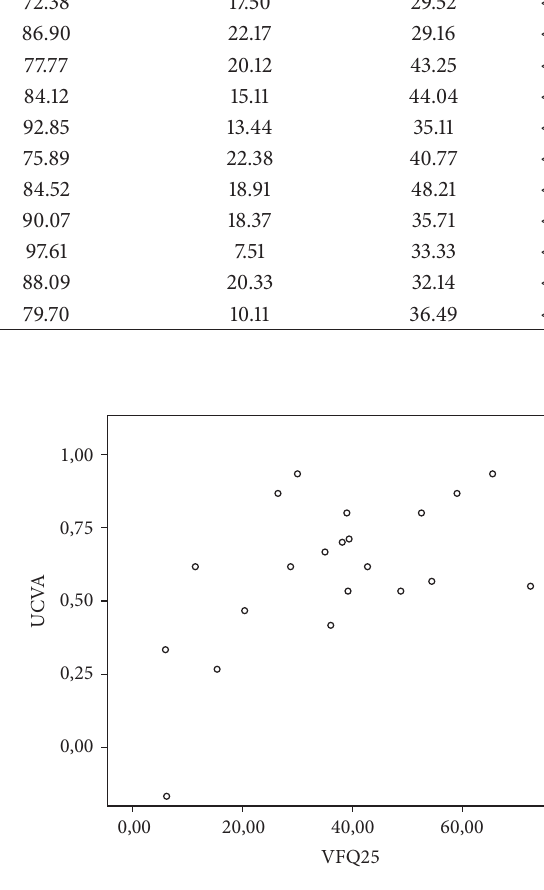
Figure 6: Scatterplot showing the significant correlation between UCVA and total questionnaire score as per the Pearson’s coefficient of 0.548 ( 𝑝 = 0.005